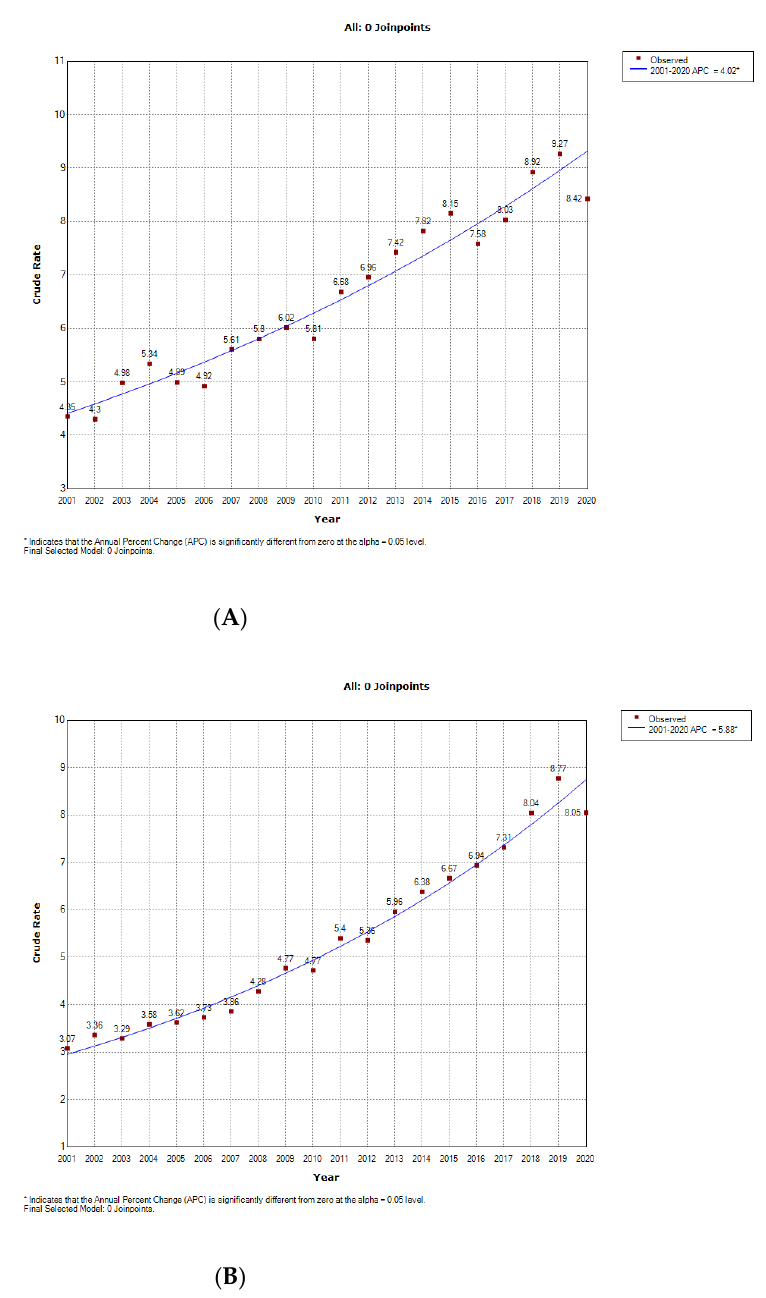
Figure 1. Joinpoint regression to assess time trend in the incidence per 100,000 inhabitants of hospitalizations with sarcoidosis in Spain from 2001 to 2020, according to sex. ( A ) Women. ( B ) Men.